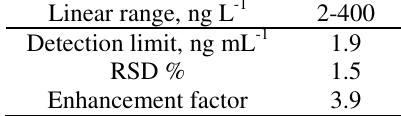
Table 1. Specification of method at optimum conditions for silver ion